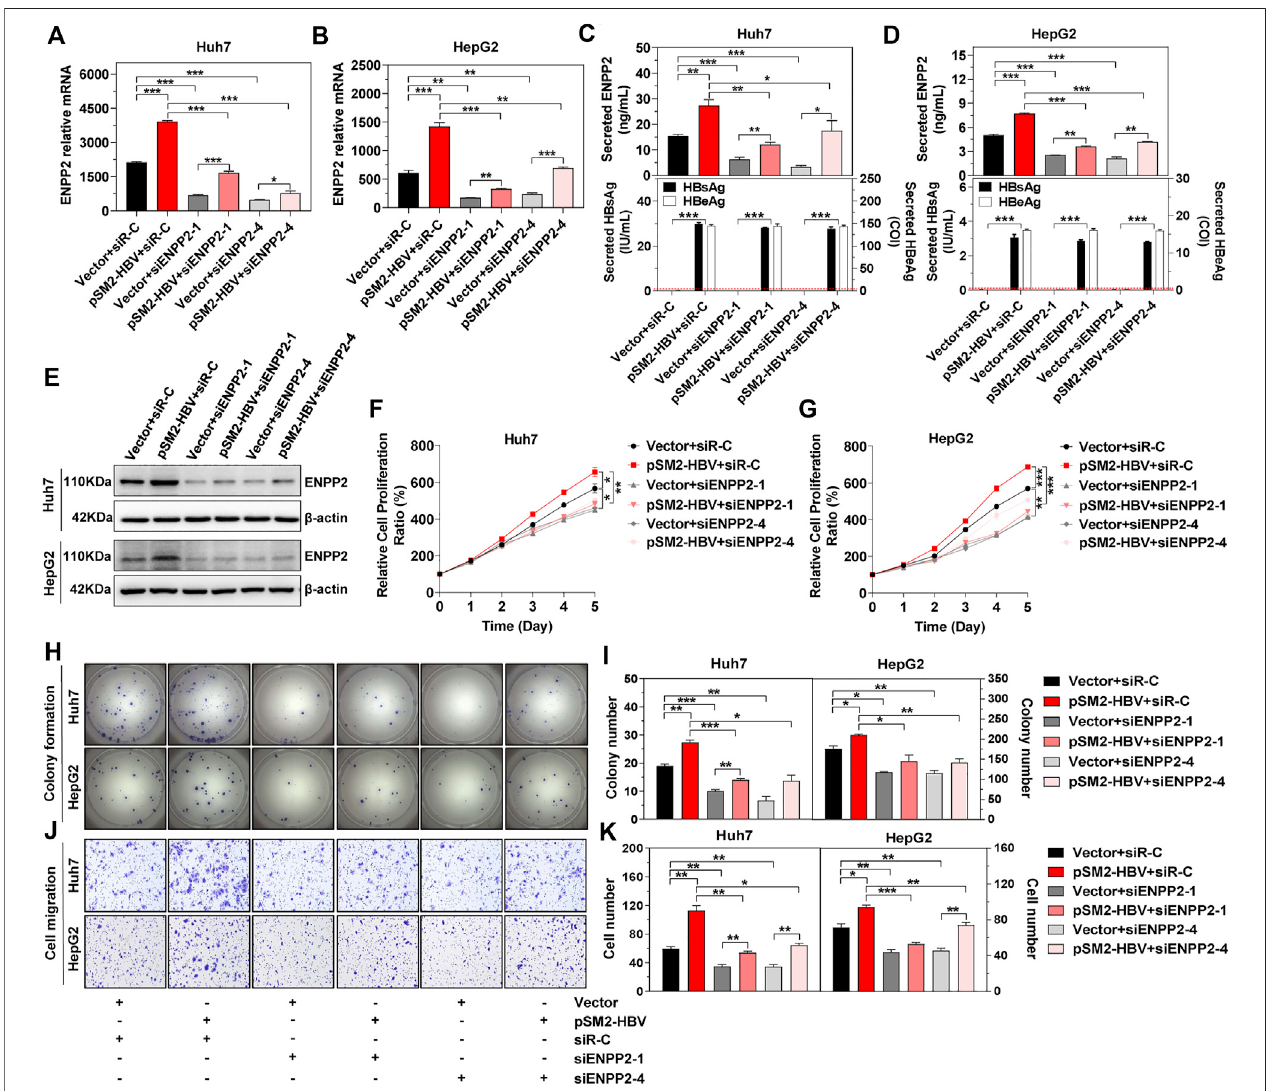
FIGURE 3 | HBV enhances hepatoma cell proliferation, colony formation, and migration, and was impeded by knocking down of ENPP2 expression. Hepatoma cells were fi rstly transfected with vector or pSM2-HBV for 1 day (set as day 0), and then transfected with siR-C or siENPP2. (A, B) The level of enpp2 mRNA in Huh7 (A) and HepG2 (B) after being transfected with siRNAs for 3 days. (C, D) Secreted ENPP2, HBsAg, and HBeAg in supernatants from Huh7 (C) and HepG2 (D) after being transfected with siRNAs for 3 days. The red dotted line in the graph represents the cutoff for HBsAg and HBeAg. (E) The intracellular ENPP2 expression in Huh7 (upper panels) and HepG2 (below panels) after being transfected with siRNAs for 3 days. (F, G) The cell proliferation ability for Huh7 (F) and HepG2 (G), respectively. (H) Representative images of colony formation for Huh7 (upper panels) and HepG2 (below panels) , respectively. (I) The bar graph of colony number indicated quantitative analysis data for Huh7 (left panel) and HepG2 (right panel) , respectively. (J) Representative images of the cell migration assay for Huh7 (upper panels) and HepG2 (below panels) , respectively (magni fi cation × 100). (K) The bar graph of cell number migrated from Transwell indicated quantitative analysis data for Huh7 (left panel) and HepG2 (right panel) , respectively. The statistical analysis was based on three replicates. *, p < 0.05; **, p < 0.01; ***, p < 0.001.